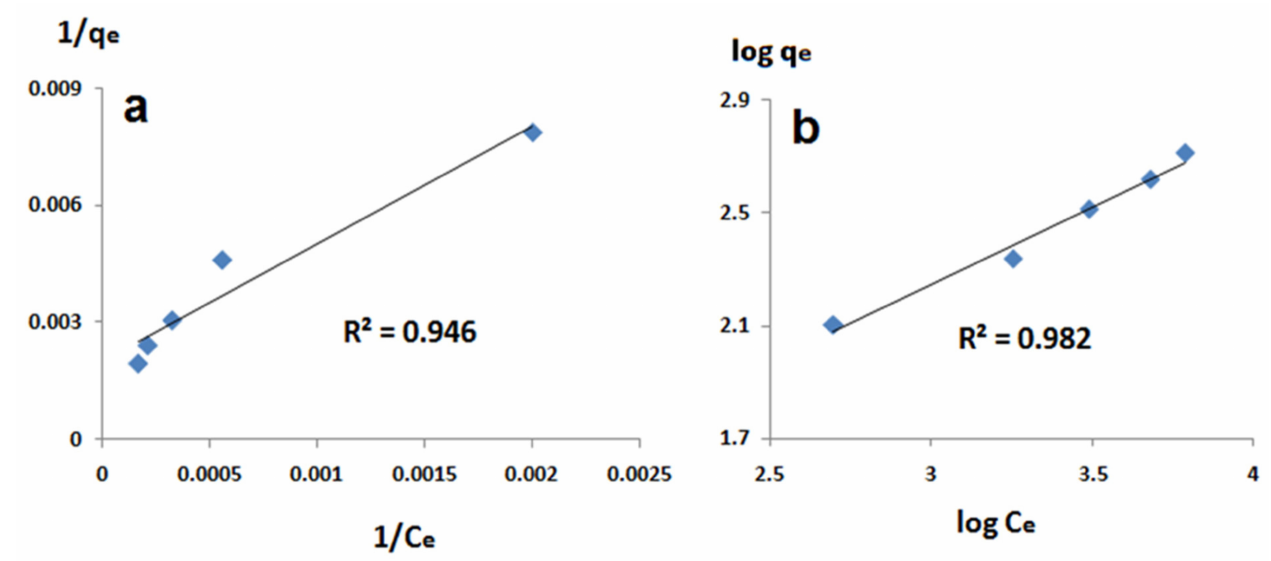
Figure 7. Linearized adsorption isotherms: ( a ) Langmuir isotherm and ( b ) Freundlich isotherm of sheep dung ash.